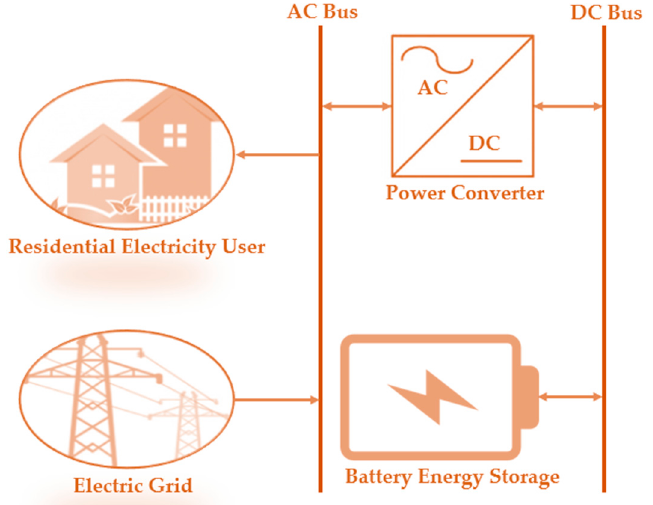
Figure 5. Schematic view of EG + BES based power supply system configuration [Note: EG—Electric grid; BES—Battery energy storage; DC—Direct current; AC—Alternating current.]